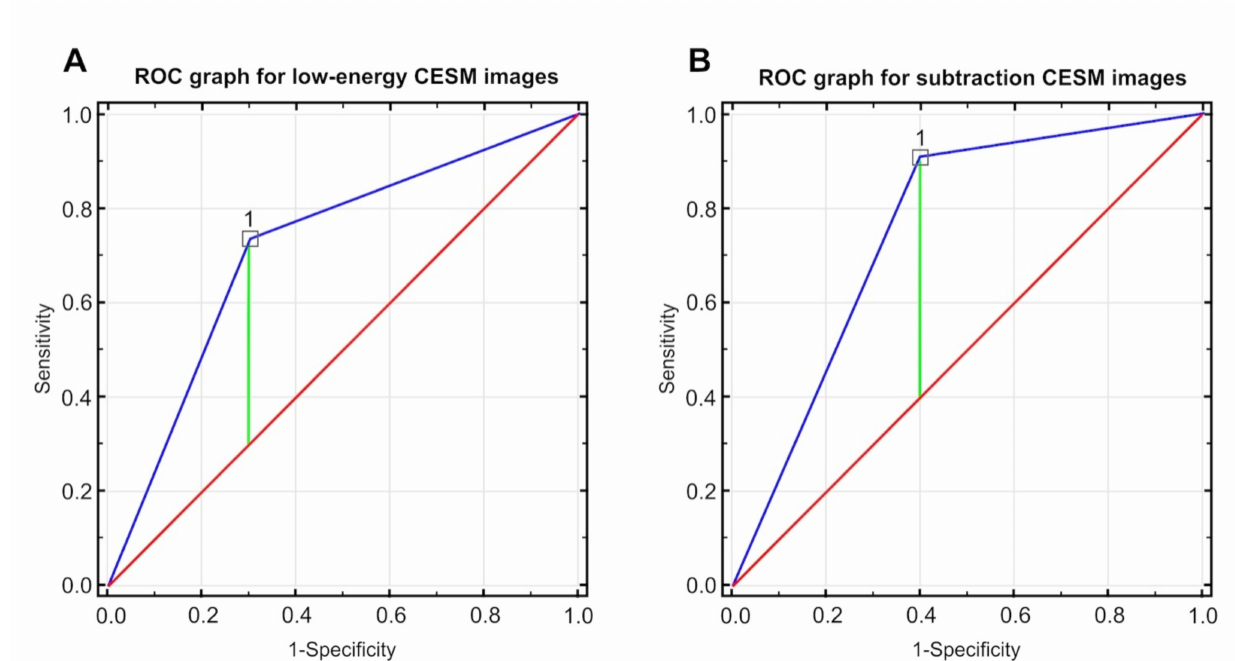
Figure 3. ROC curves based on the tested diagnostic methods (Youden Index:0.44, proposed cut-off point: 1.00): ( A ) for low-energy CESM images, the value of the AUC field was 0.718 at a standard error of 0.091 and p < 0.0172; ( B ) for subtraction CESM images, the value of the AUC field was 0.755 at a standard error of 0.064 and p < 0.0001.